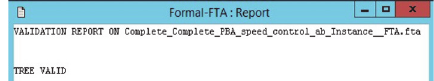
Figure 5: FTA validation report.